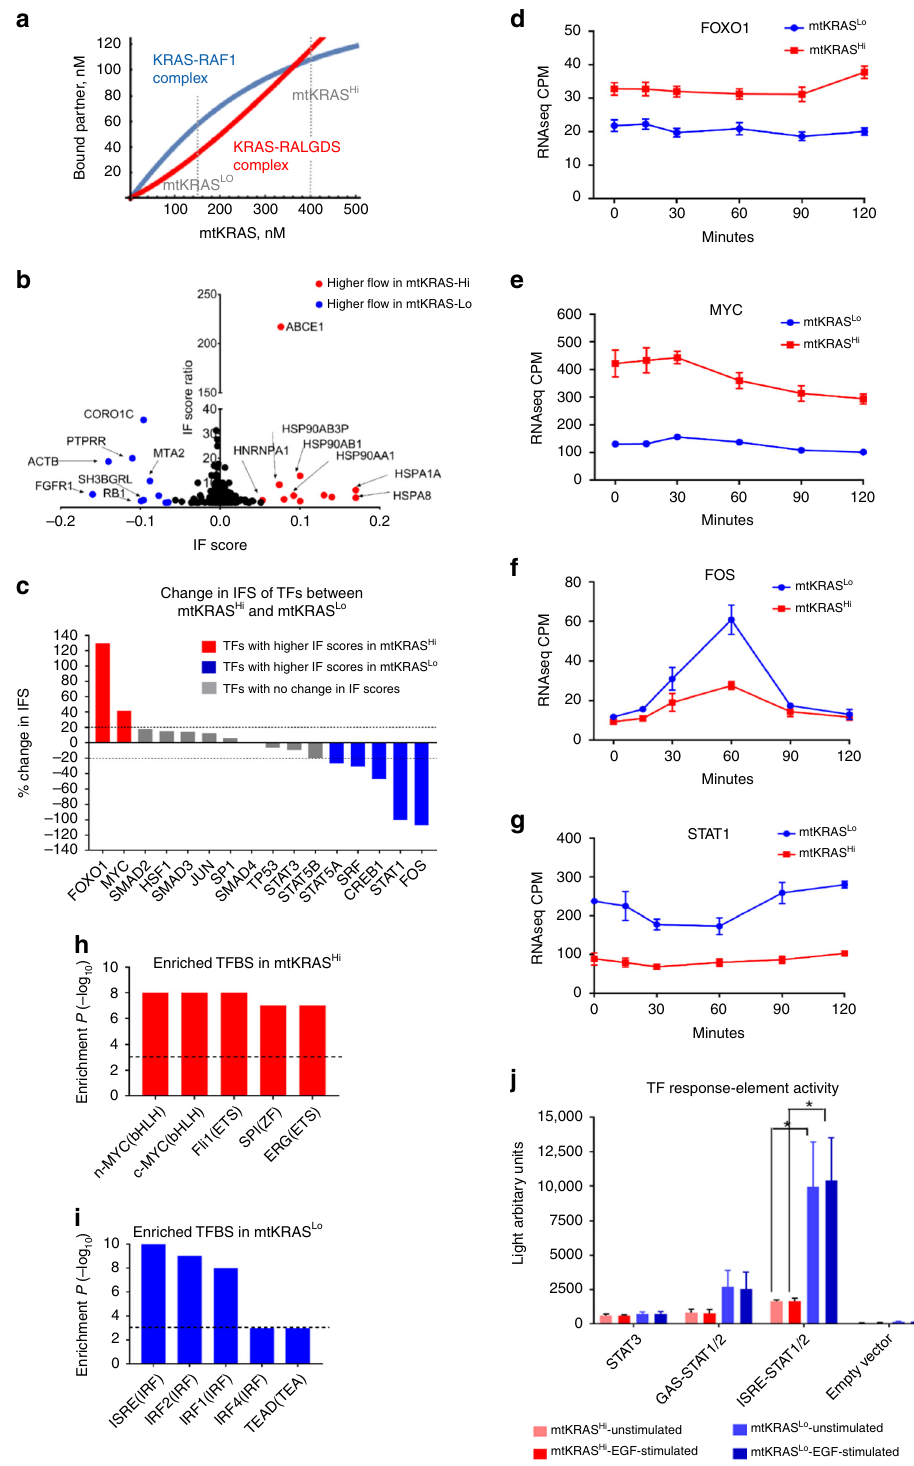
Fig. 5 KRAS effector pathway and information fl ow (IF) analysis of the EGFRNet mtKRAS-Hi and EGFRNet mtKRAS-Lo networks. a Dependence of KRAS- effector complex concentrations of effectors binding with high (RAF1, blue) or low af fi nity (RALGDS, red) on the abundance of mtKRAS. Broken gray lines indicate KRAS concentrations in mtKRAS Lo and mtKRAS Hi cells. b Plot showing nodes in the top 5th percentile in terms of their IFS and predicted to receive more fl ow in EGFRNet mtKRAS-Hi (red) or EGFRNet mtKRAS-Lo (blue). c Transcription factors (TFs) with at least 20% higher information fl ow in EGFRNet mtKRAS-Hi (red) and EGFRNet mtKRAS-Lo (blue). Gene expression of d FOXO1, e MYC, f FOS, and g STAT1 as determined by RNAseq analysis of TGF α stimulated cells. ***EdgeR FDR < 0.001; ****EdgeR FDR < 0.0001. The top fi ve enriched transcription factor binding (TFBS) site motifs in the promoters of genes upregulated in h mtKRAS Hi and i mtKRAS Lo cells. j Reporter gene assays of the activity of STAT1/2 and STAT3. Error bars represent standard deviation, and P values in K were determined by a two-tailed Student ’ s t -test. * P < 0.05; ** P < 0.01. The data represent three independent experiments. Source data are provided as a Source Data fi le. Mathematica code for 5A is provided in Supplementary Software